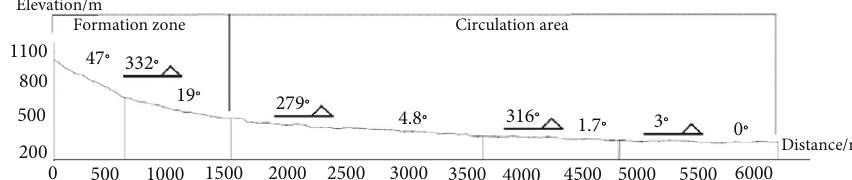
Figure 3: Longitudinal section of Nanjiaogou main